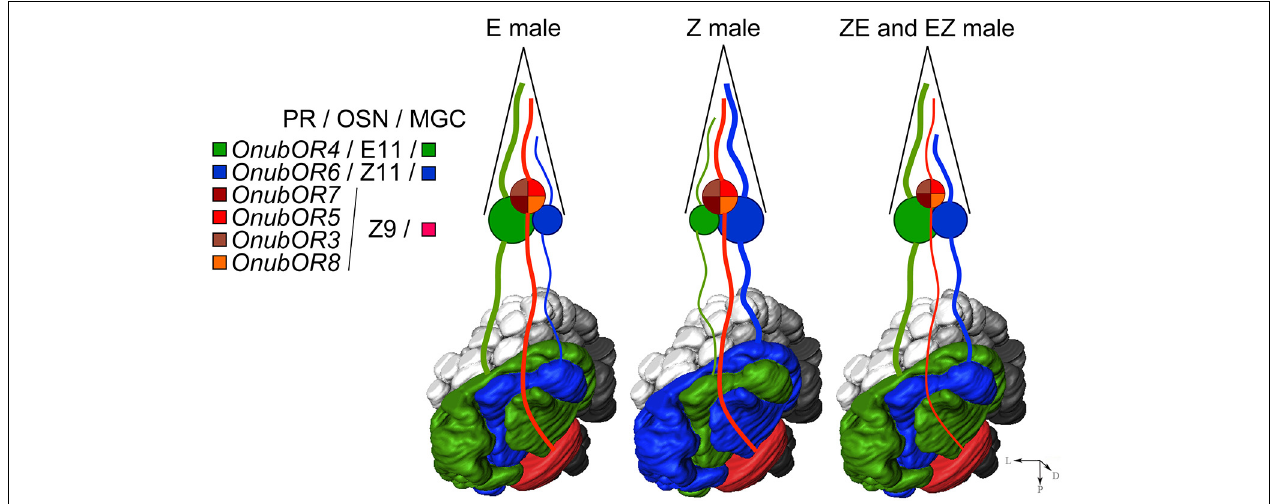
FIGURE 6 | Hypothetical scheme of O. nubilalis pure strains and hybrids sex-pheromone circuit between the antenna and the MGC in the antennal lobe.